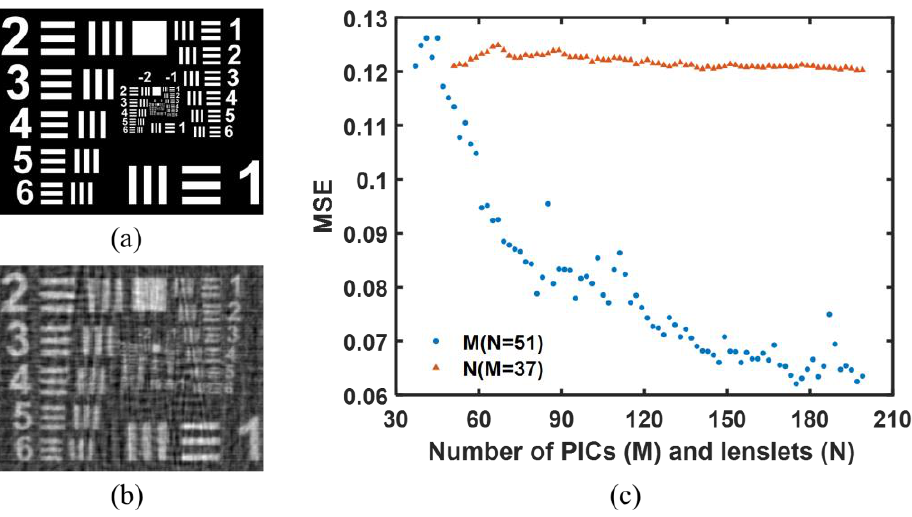
Figure 3. Imaging result with different parameters. ( a ) Original image; ( b ) Imaging result with the parameters in Table 1; ( c ) The number of PICs and lenslets versus the mean square error